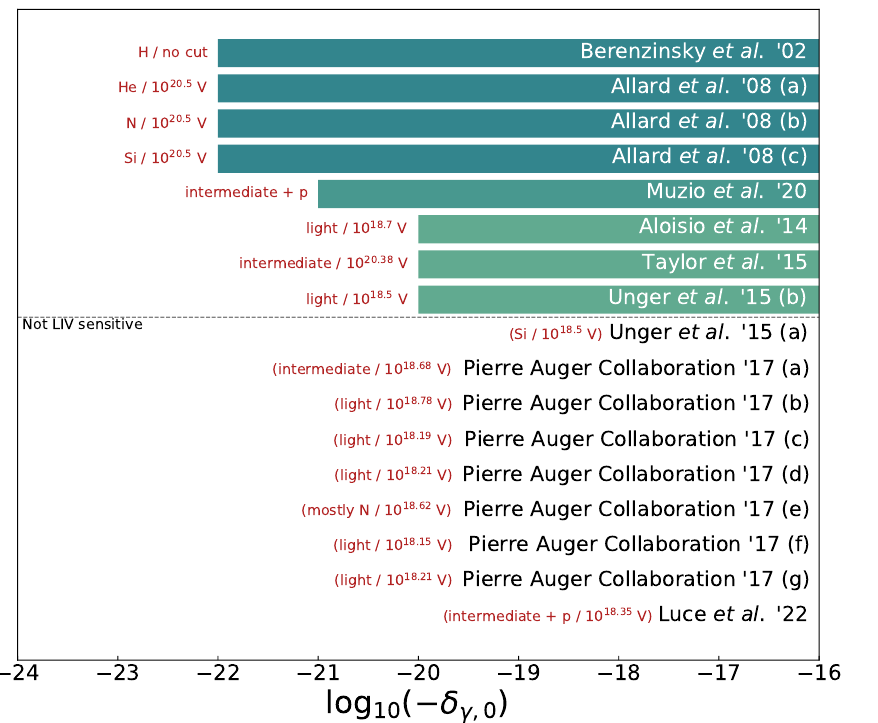
Figure 4. Logarithmic order of the limits on subluminal LIV of order n = 0 imposed for each UHECR model. The models below the dashed lines are insensitive to LIV using this technique and, thus, no limits could be imposed. The red texts show a brief description about the two leading features of the models: its composition and maximum attainable rigidity at the sources.